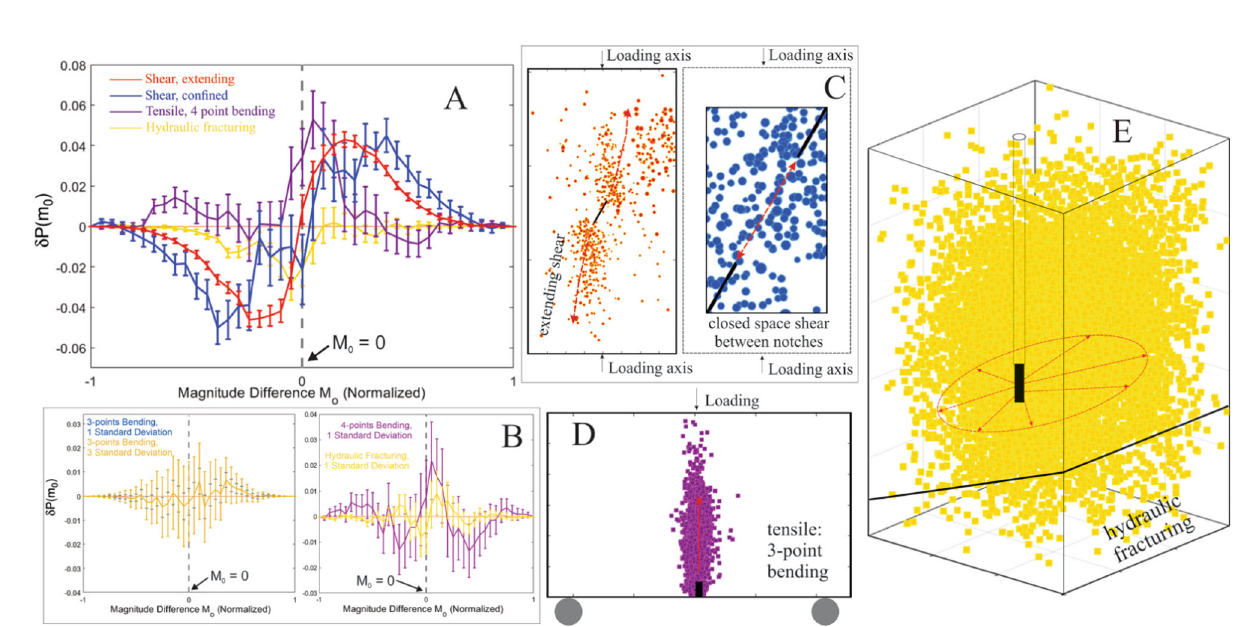
Fig. 5 | Magnitude clustering in laboratory earthquakes. A Normalized magni- tude clustering phenomena for various types of rock fractures on different rock types. Absolute M 0 spans of the curves are varied as tests are conducted on dif- ferent rock types with different data acquisition systems. B The non-clustering observations on the whole catalogs of the rock fractures under dominatingly